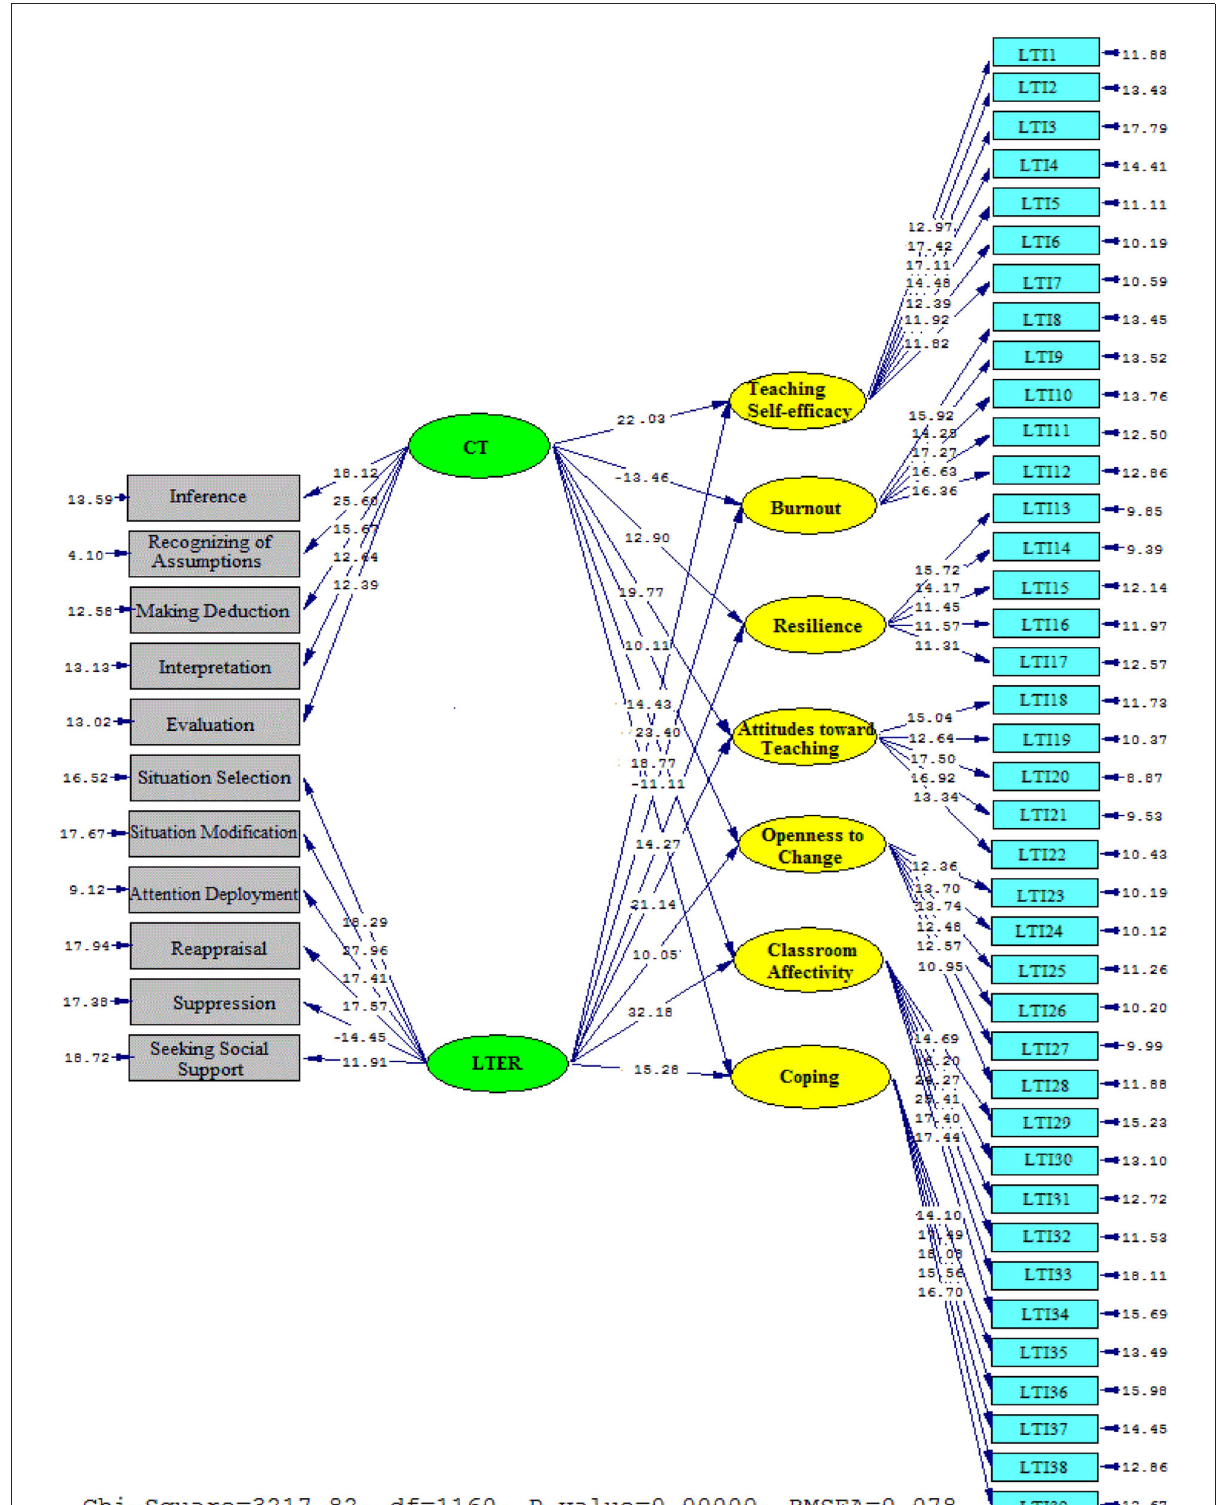
FIGURE5 The T values for path coefficient significance (model